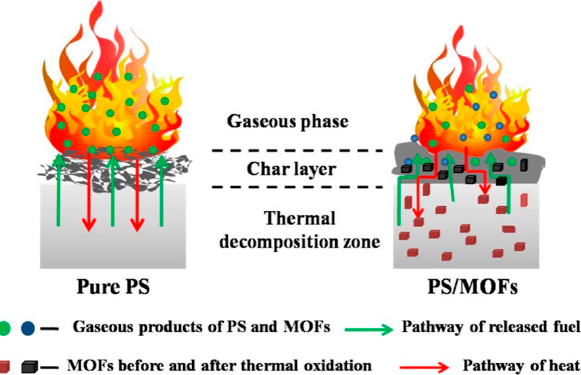
Figure 1. Proposed mechanisms for illustration of the thermal stability flame retardancy of PS and its composites. Reprinted with permission from Ref. [27]. Copyright 2017, American Chemical Society.